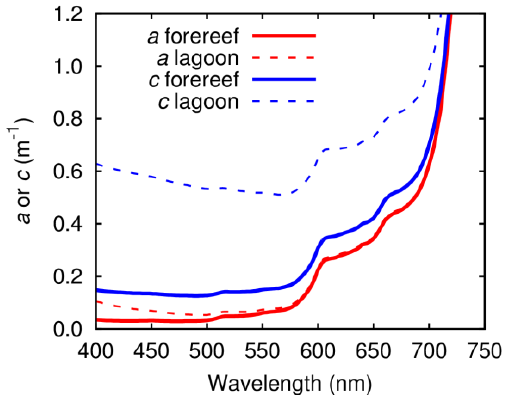
Figure 2. Total absorption, a ( λ ), and attenuation, c ( λ ), as used in the two water column inherent optical property (IOP) treatments, forereef and lagoon (includes the contribution of pure water itself).